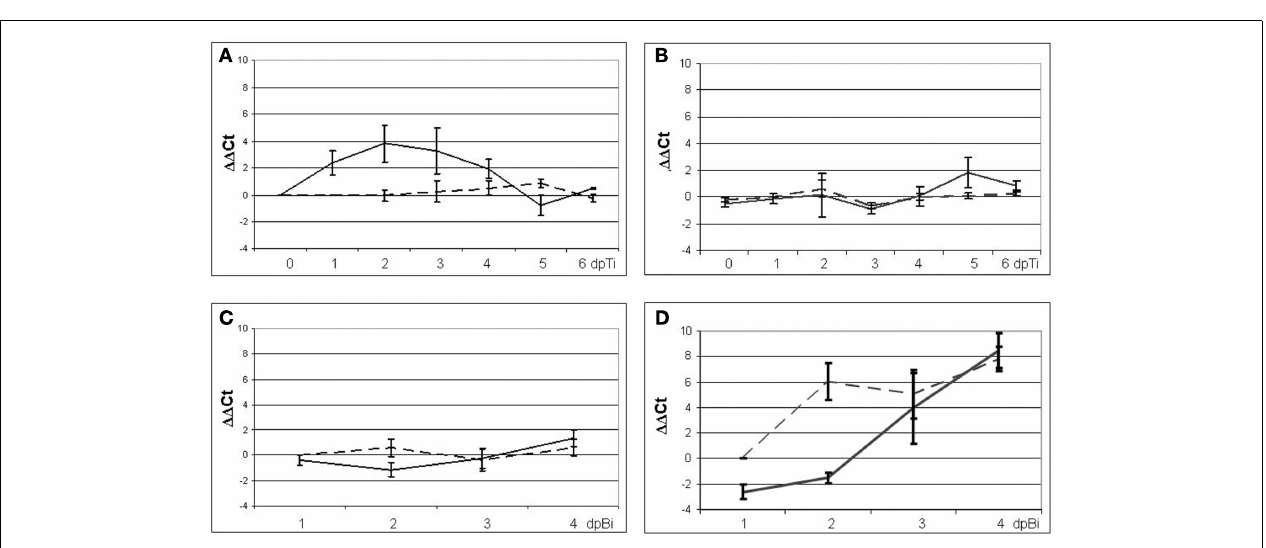
replicates) collected on six consecutive days after T. hamatum T382 administration. For ISR-boost gene expression analysis of PR1 (C) and PDF1.2a (D) was done in five samples (biological replicates) collected on four consecutive days after B. cinerea inoculation.